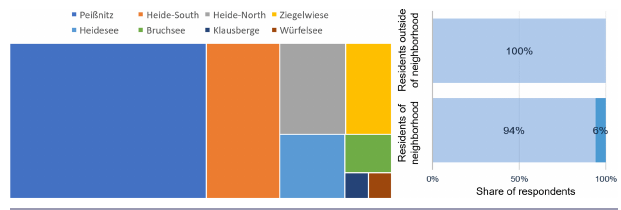
Fig. 8 . Frequency of urban green spaces within and beyond Halle-Newtown mentioned in the 100 mental maps.